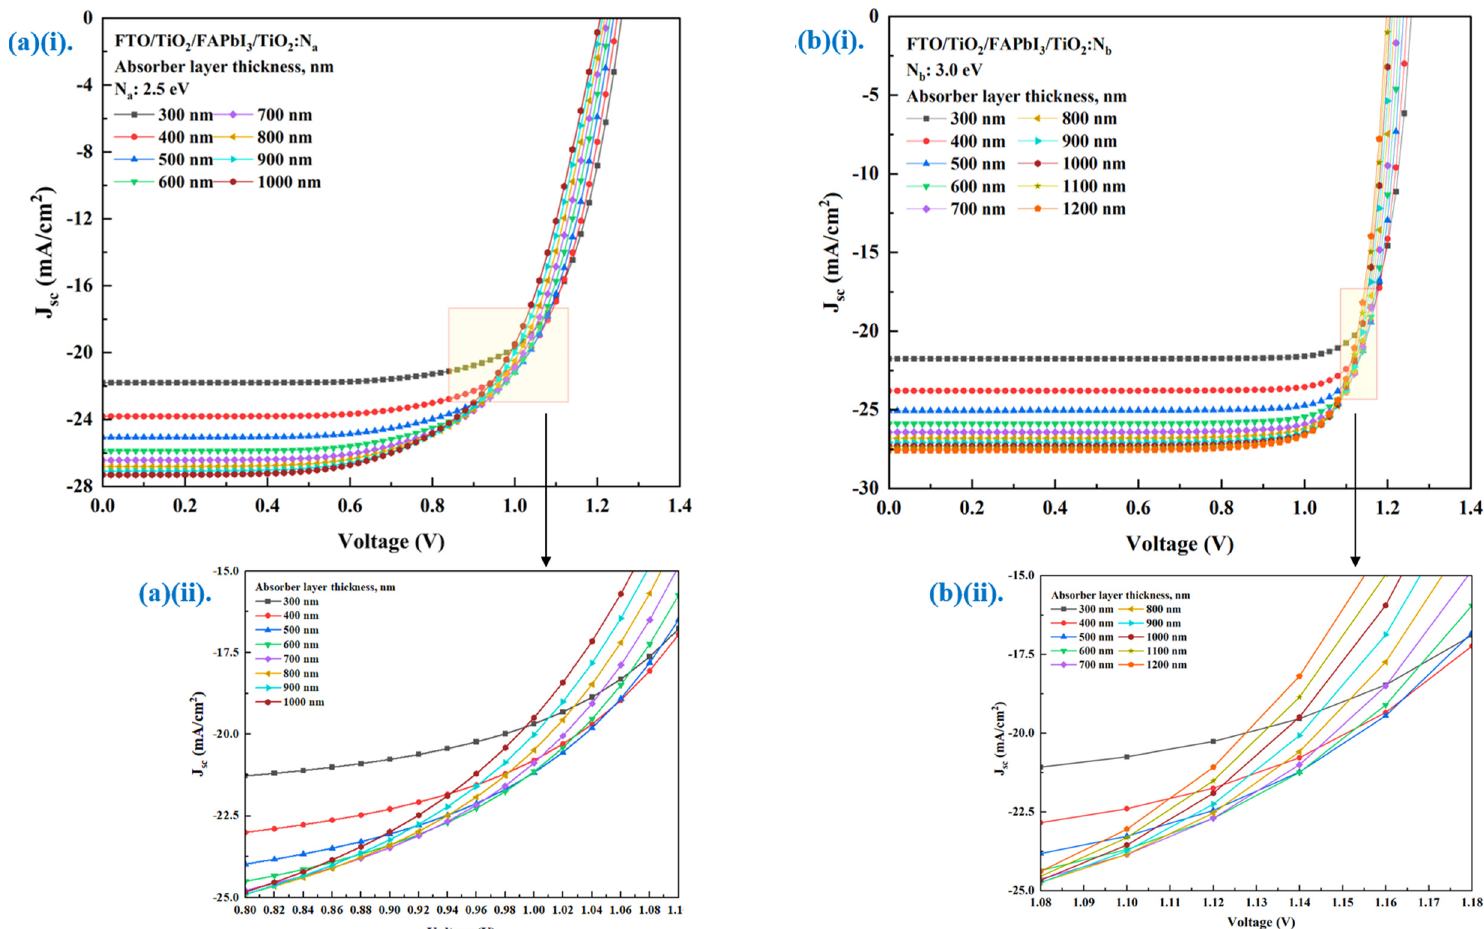
Figure 3. ( a ) ( i ) J-V characteristic curve for the FTO/FAPbI 3 /TiO 2 :N a recipe with ∆ t; ( ii ) a magnified view of the convergence point from the applied voltage range 0.8–1.1 V. ( b ) ( i ) J-V characteristic curve for the FTO/FAPbI 3 /TiO 2 :N b recipe with ∆ t; ( ii ) a magnified view of the convergence point in the applied voltage range 1.08–1.18 V.